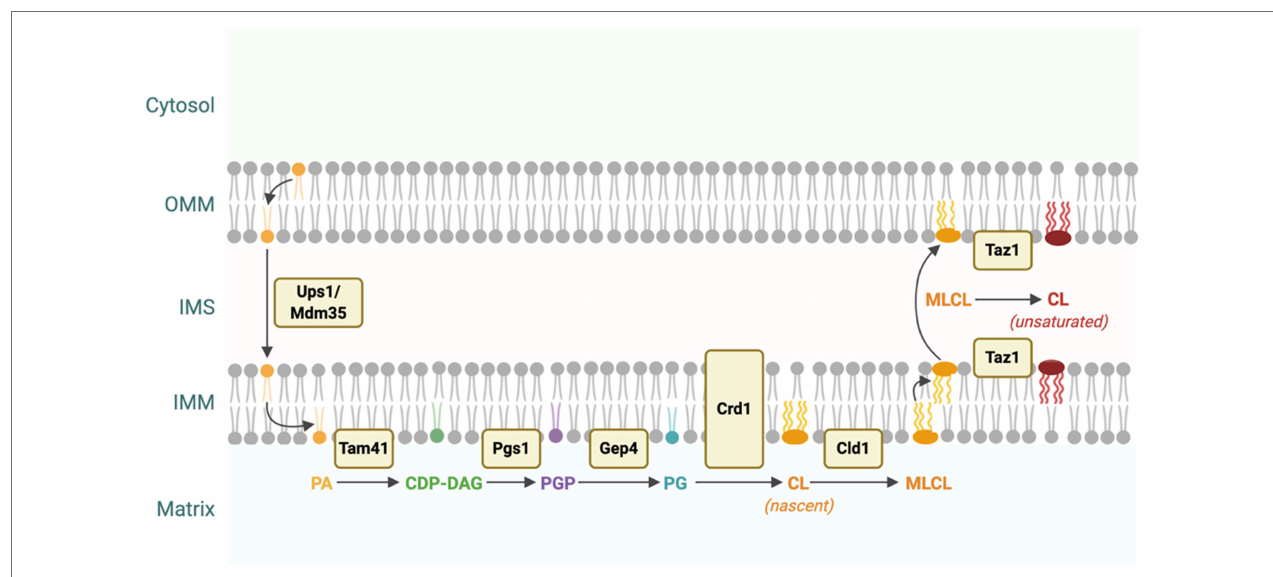
FIGURE 1 | Cardiolipin (CL) biosynthesis in yeast. CL is synthesized from phosphatidic acid (PA) through a four-step process. PA is translocated from the outer mitochondrial membrane (OMM) to the IMM via the Ups1/Mdm35 protein complex (Potting et al., 2010; Tamura et al., 2010; Connerth et al., 2012). PA is converted into cytidine diphosphate diacylglycerol (CDP-DAG), phosphatidylglycerol phosphate (PGP), and then phosphatidylglycerol (PG) by Tam41, Pgs1, and Gep4, respectively (Chang et al., 1998a; Osman et al., 2010; Blunsom et al., 2018). Finally, PG is converted to nascent CL by the enzymatic activity of Crd1. Nascent CL, which contains predominantly saturated acyl chains, is remodeled through several cycles of deacylation and reacylation catalyzed by Cld1 and Taz1 to form primarily unsaturated CL (Xu et al., 2006; Beranek et al., 2009). This figure was created with